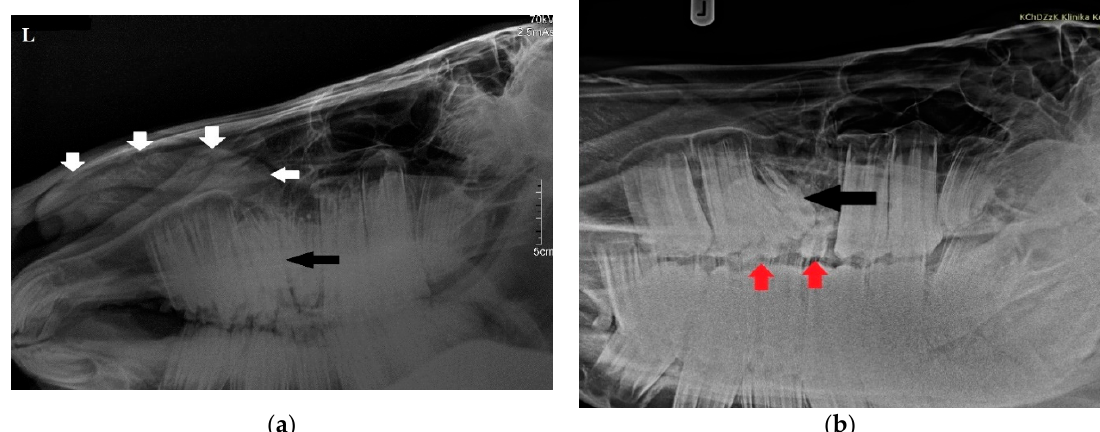
Figure 2. ( a ) Radiographic examination in latero-lateral projection demonstrating a well-demarcated mass within the nasal cavity (white arrows) and displaced Triadan 208 (black arrow). ( b ) Rt30D-LeVO projection of the maxillary region revealing hypoplastic dislocated maxillary last premolar (black arrow). Clearly visible deciduous Triadan 607 and 608 (red arrows).